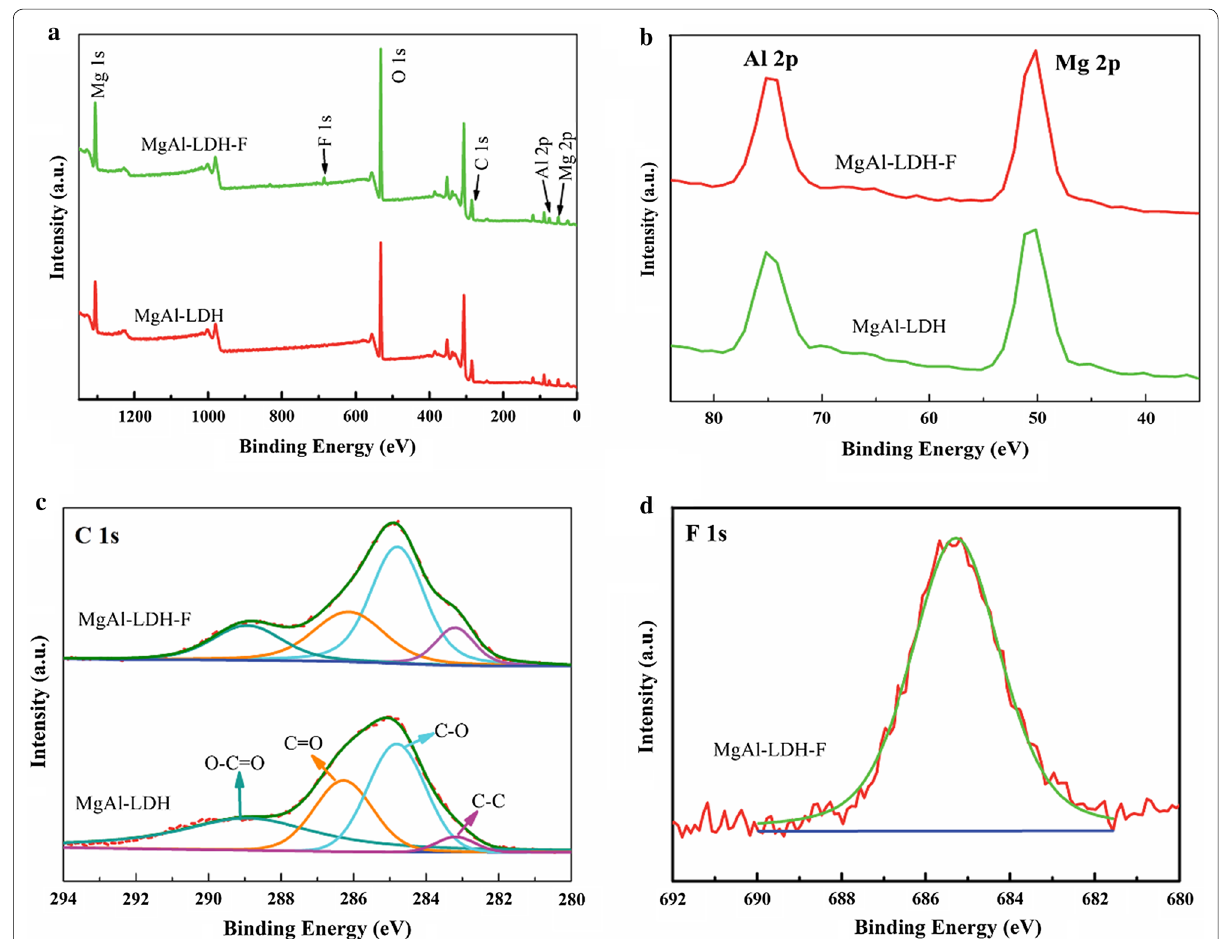
Fig. 5 a Survey XPS spectrum of MgAl-LDH and MgAl-LDH-F, high-resolution XPS spectra of b Al 2p and Mg 2p, c C 1s and d F